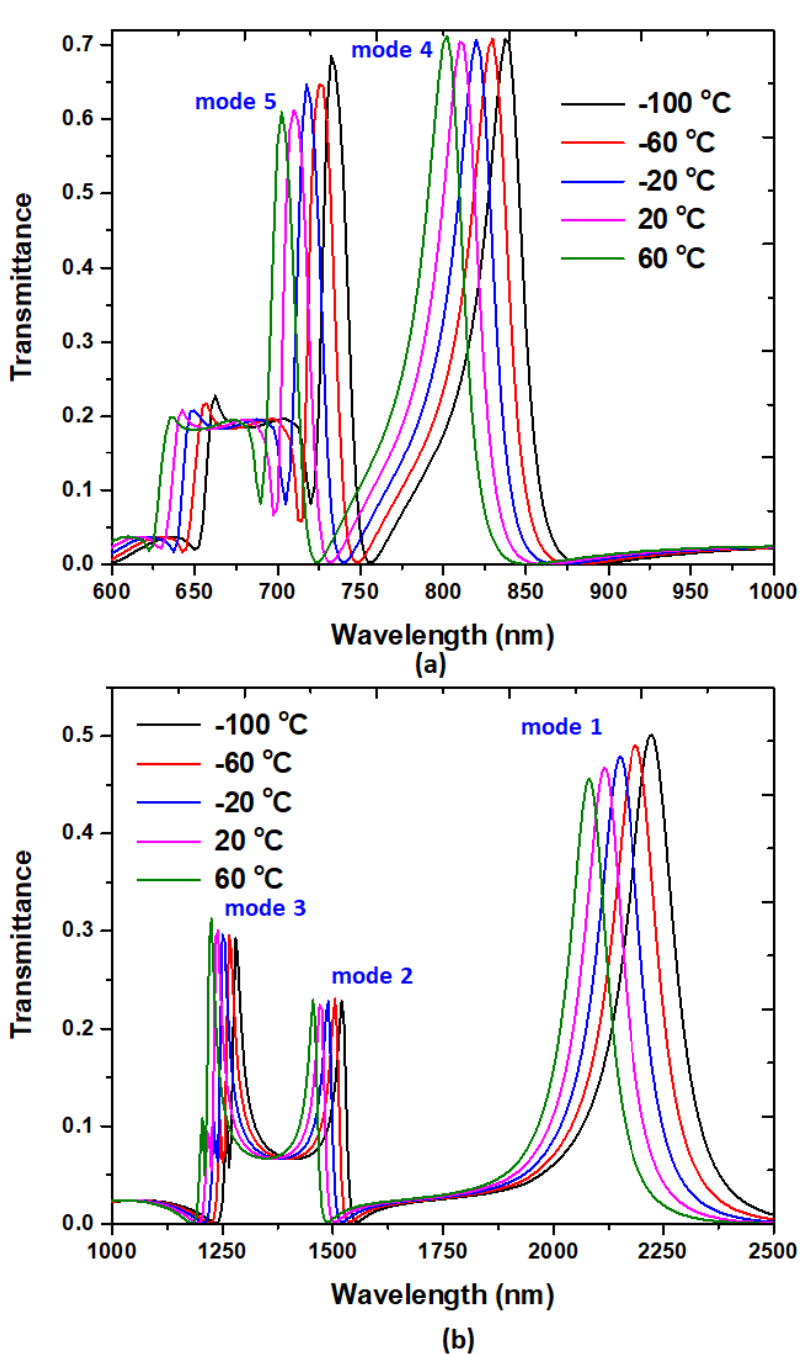
Figure 7. Transmittance spectrum of the proposed case 4 structure at various ambient temperatures ( T ) in the wavelength range of ( a ) 600–100 nm and ( b ) 1000–2500 nm. The other parameters remain unchanged from Table 2.